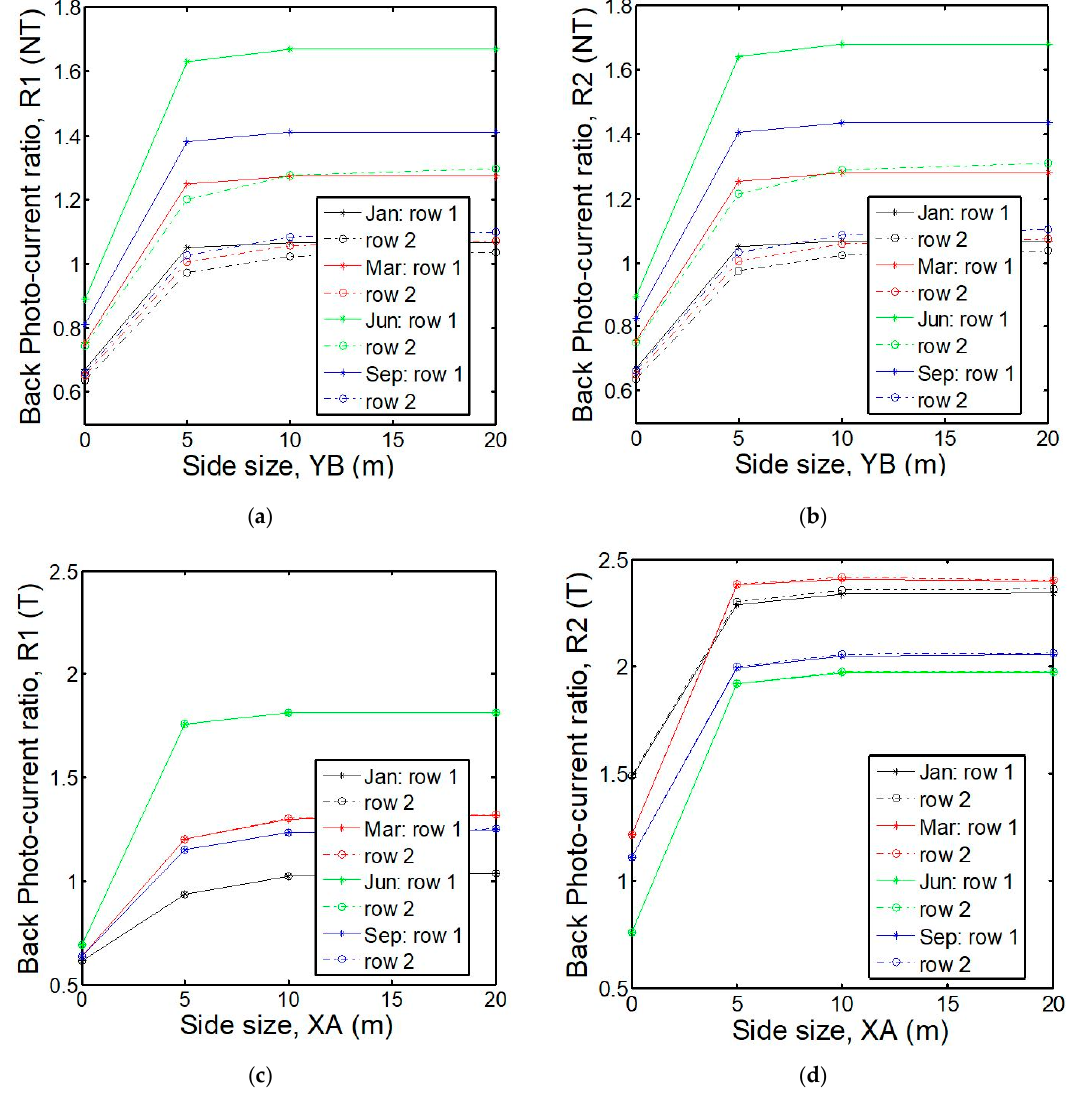
Figure 7. Daily average values of the ratios R1 = I sc,back,M.1 /I sc,back,M.7 and R2 = I sc,back,M.15 /I sc,back,M.7 (see the main text for the symbol meaning), as a function of the YB and XA parameters, for the two rows of the considered 30-module PV strings: fixed string ( a ),( b ) and string with uniaxial horizontal solar tracker ( c ),( d ). The mentioned ratio values were calculated by the model, considering the Catania (Italy) latitude, at different solar times of four days of 2018 (January 15th, March 20th, June 15th, and September 15th).